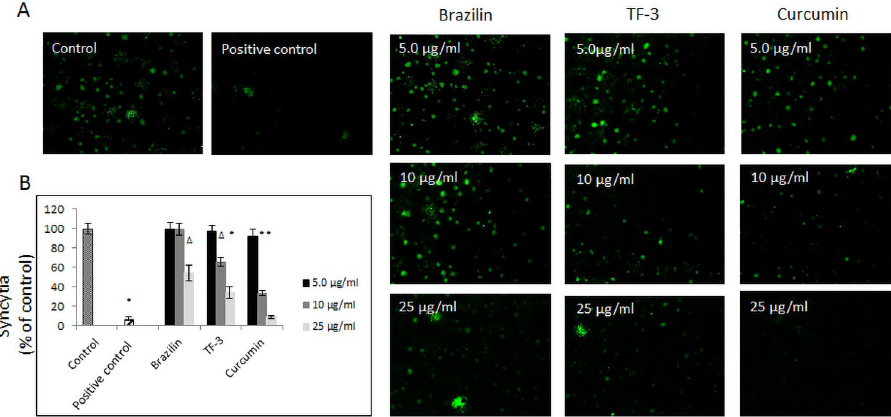
Fig 4. Effect of selected polyphenols on fusion to human ACE2 receptor overexpressing A549 cells. (A) Cell-cell fusion of A549 cells expressing eGFP spike protein with A549 cells stably expressing human ACE2 receptor. The scale bar indicates 250 μ m. (B) Quantitative analysis of formed syncytia. Experiments were done in triplicate and repeated three times. Data are presented as % of control ± SD; TF-3 –theaflavin-3,3’-digallate Δ p � 0.01, � p � 0.001. Control– 0.025% DMSO, positive control– 20 μ g/ml anti-ACE2 antibody.